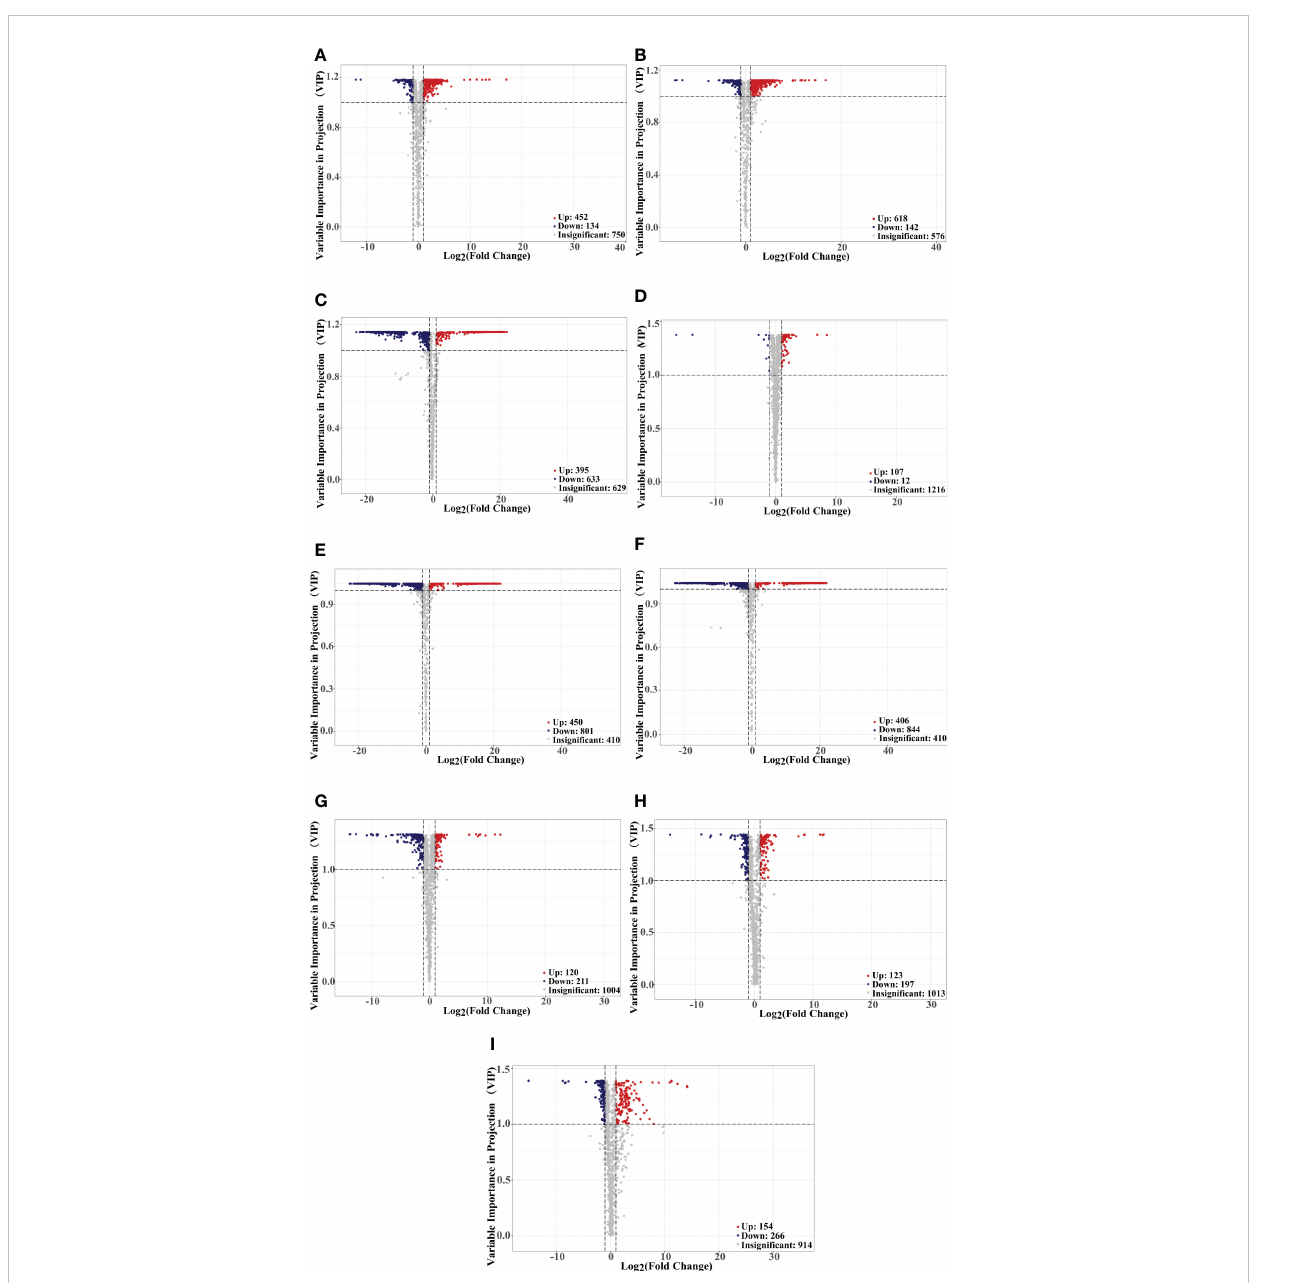
FIGURE 4 Volcano plots showing the differences in the expression levels of metabolites in red raspberry, red spots indicate up-regulated differentially expressed metabolites; blue spots indicate down-regulated differentially expressed metabolites, and grey spots indicate detected metabolites, the differences were not signi fi cant at p < 0.05, Y-R vs Q-R, Y-RP vs Q-RP, Y-RS vs Q-RS, Q-R vs Q-RP, Q-R vs Q-RS, Q-RP vs Q-RS, Y-R vs Y-RP, Y-R vs Y-RS, and Y-RP vs Y-RS (A – I)